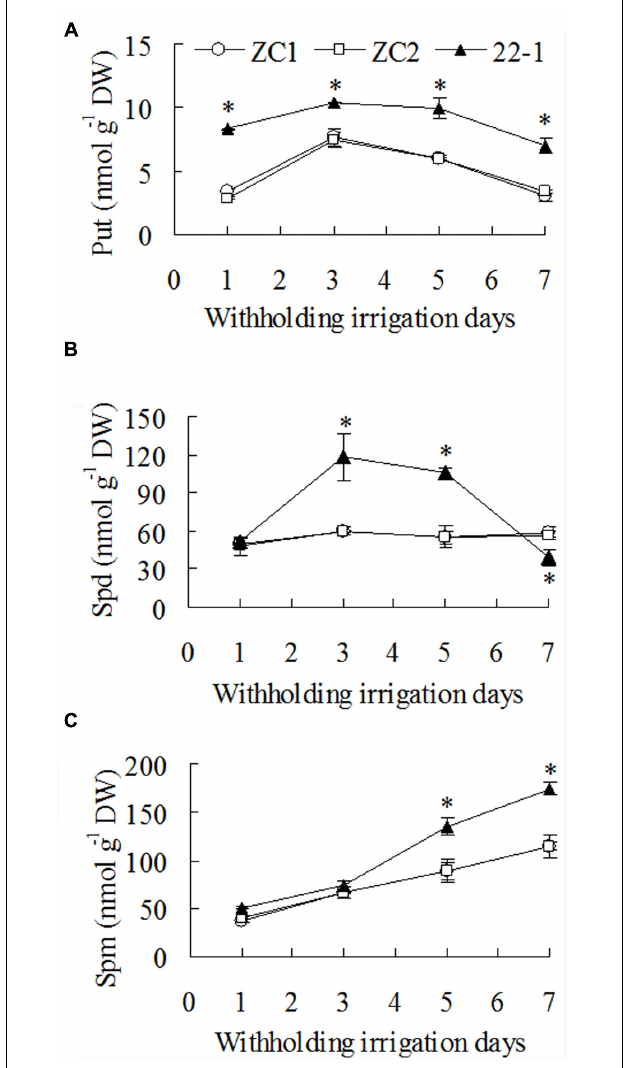
FIGURE 4 | Putrescine (Put, A) , spermidine (Spd, B ), and spermine (Spm, C ) levels in the mutant 22-1 in comparison with two wild type plant lines (ZC1, ZC2) in response to drought stress. Means of three independent plant samples and the standard errors are presented; an asterisk indicates significant difference between 22-1 and the wild types at P < 0.05 at a given time.